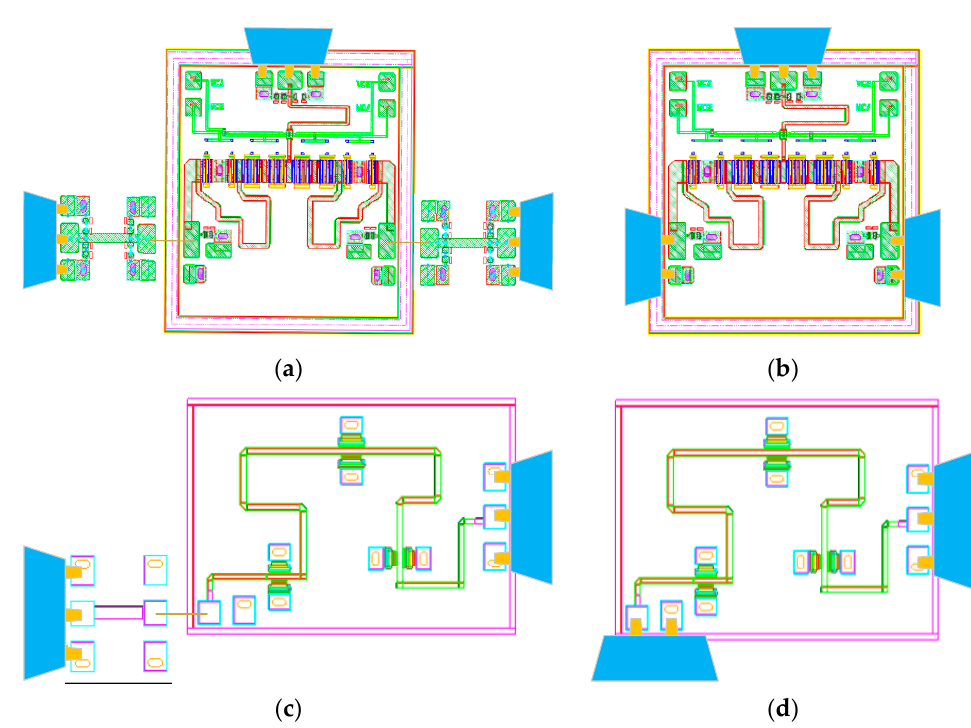
Figure 1. Illustration of hybrid balanced and unbalanced MMIC test structure and methods with RF probes, with ( a , b ) corresponding to GSG ‐ GSG test method after bonding and SG ‐ GS test m ethod of switch, ( c , d ) corresponding to GSG ‐ GSG test method after bonding and SG ‐ GS test m ethod of limiter.